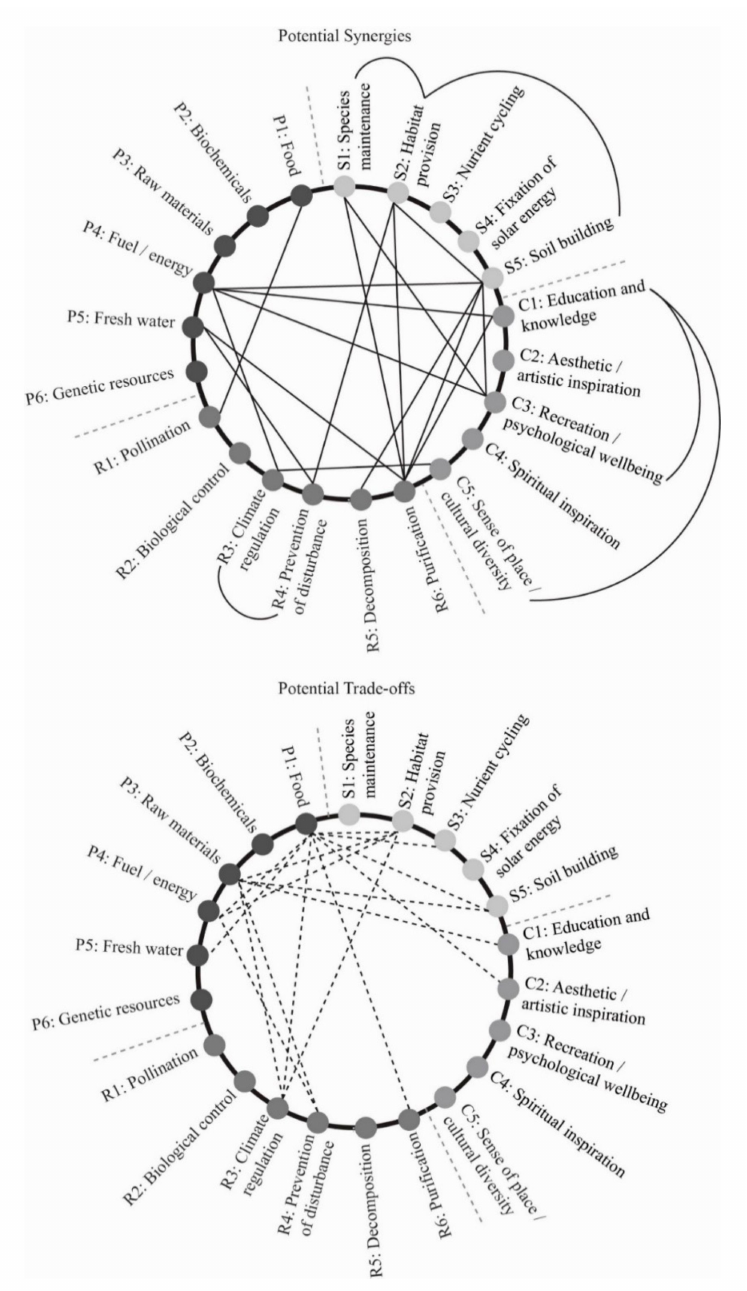
Figure 1. Diagrams of the relationships between ecosystem services (source: